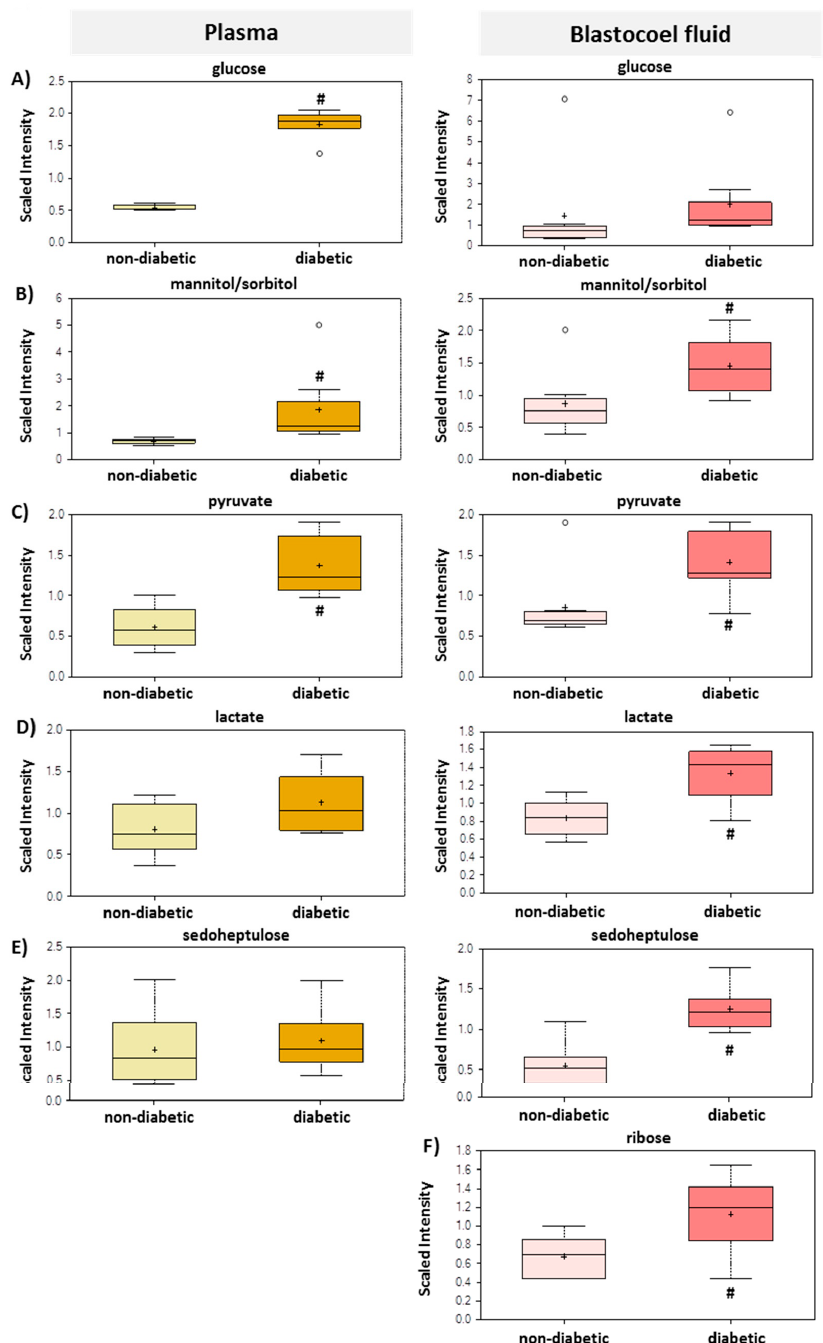
Figure 2. Selected biochemicals of carbohydrate metabolism detected in plasma and blastocoel fluid of non-diabetic and diabetic rabbits at day 6 post-coitum. Boxes in light yellow, red, plasma, and BF from non-diabetic rabbits, in dark yellow and red from diabetic rabbits. Box and whisker plots for biochemical components: ( A ) glucose, ( B ) mannitol/sorbitol, ( C ) pyruvate, ( D ) lactate, ( E ) seduloheptulose, ( F ) ribose. The upper whiskers represent the maximum, and the lower whiskers the minimum values. The plus-signs indicate the mean values, while the median values are represented by a black line within the boxes. Boxes with # di ff er significantly ( p ≤ 0.05). y axis: scale intensity is calculated as followed: Each biochemical in OrigScale (raw data) is rescaled to set the median equal to